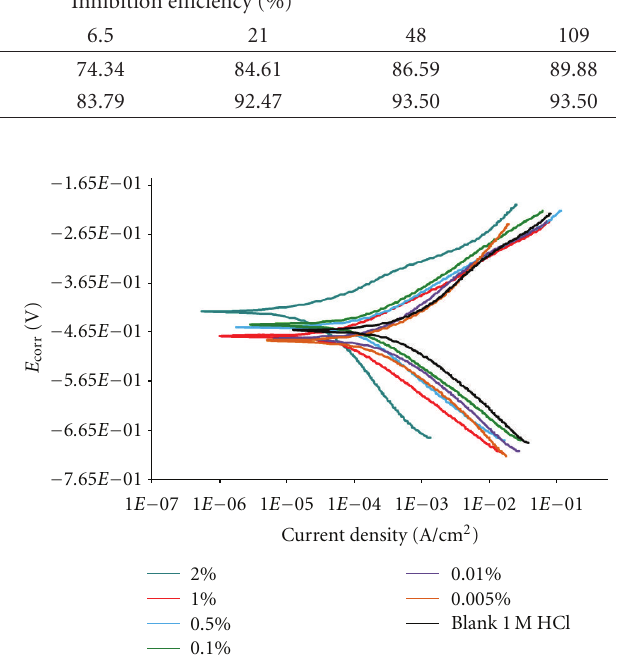
Table 2: Inhibition e ffi ciency as a function of immersion time and concentration of Pachycormus discolor ethanol extract. Inhibitor concentration % (v/v)